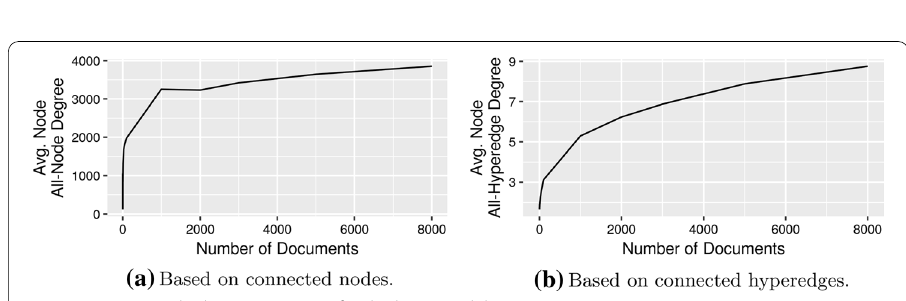
Fig. 3 Average node degree over time for the base